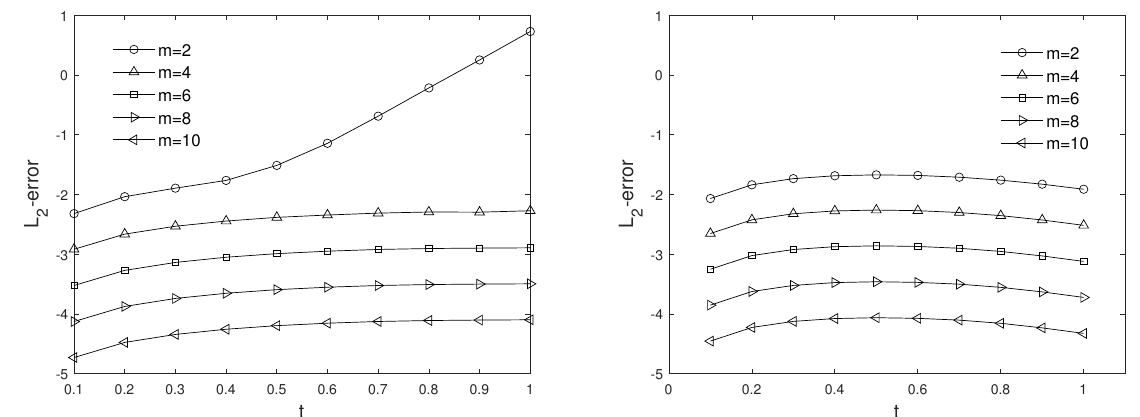
Figure 6. L 2 —error using explicit method ( left ) and implicit error ( right ) taking r = 3 and J = 2 at time δ t = 0.1/2 m − 1 for Example 2.